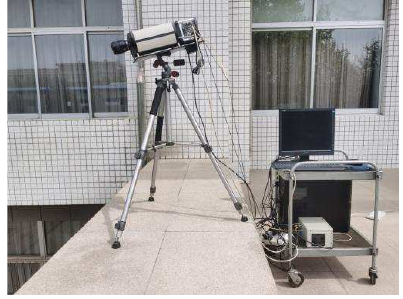
Figure 6. Imaging spectrometer.